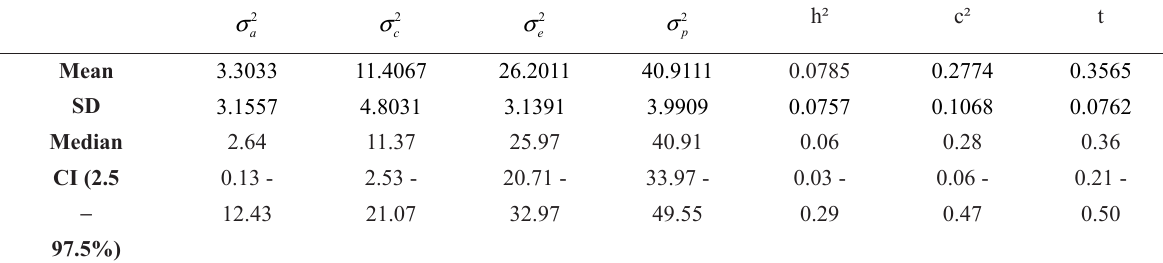
Posterior statistics for variance components and heritability for volume of eggs in Nile tilapia.